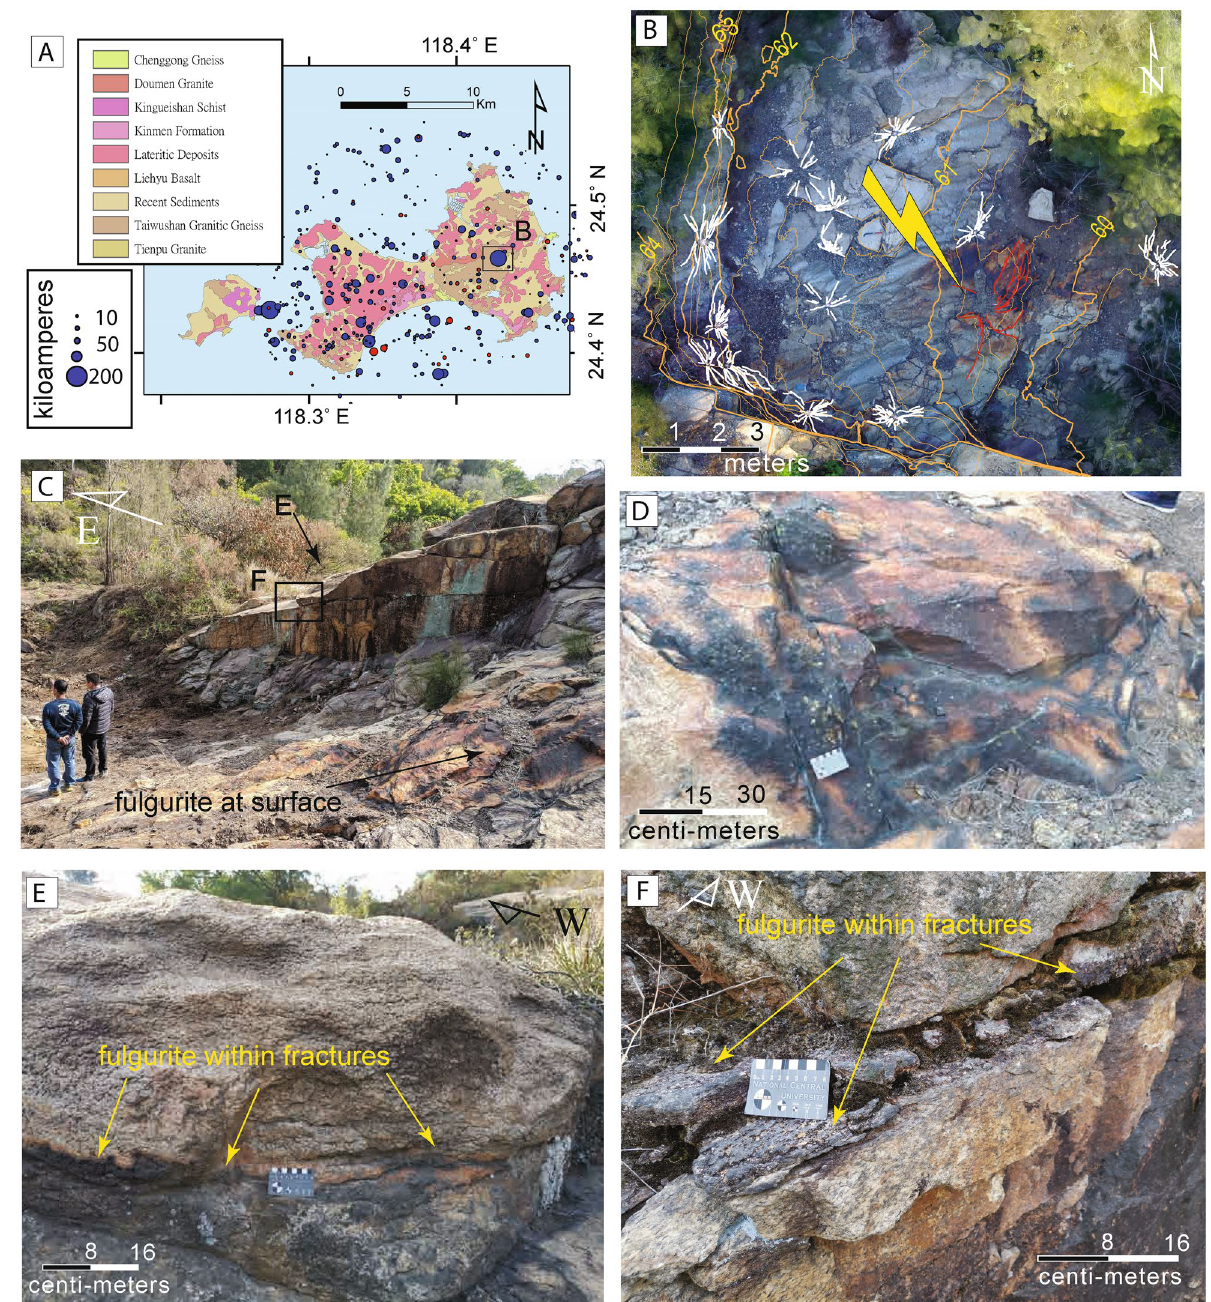
Figure 1. Geological setting of Kinmen Island, Taiwan, and the distribution of lightning on 7th May 2018. (A) Simplified geology of Kinmen Island, showing the distribution of the Taiwushan granitic gneiss. The map was created in QGIS version 3.4.14 (https:// qgis. org). Individual CG lightning strikes and their energy are indicated by the location of size of circles. (B) Map view of the fulgurite collected by unmanned aerial vehicle with contours (24°27 ′ 51.6" N 118°25 ′ 37.9" E). (C) Outcrop photograph of two fulgurites including fresh brown-black glassy crust at the surface (surface fulgurite, part (D) ) and within a shallowly-dipping fracture (fracture-related fulgurite; parts (E,F) ). (D) Patch of fresh surface fulgurite around 1 m in diameter. (E) Fulgurite surrounding a shallowly-dipping fracture in granitic gneiss that is sub-parallel to the regional gneissic exfoliation joint. (F) Detail of fracture-related fulgurite observed on a subvertical outcrop face, showing a dark